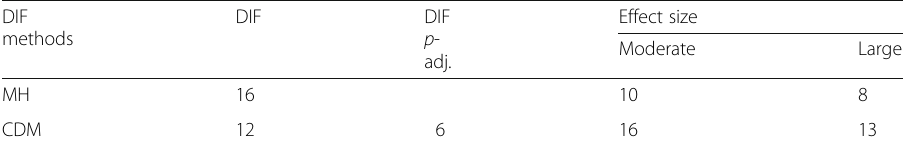
Table 10 Comparison of DIF detection methods DIF